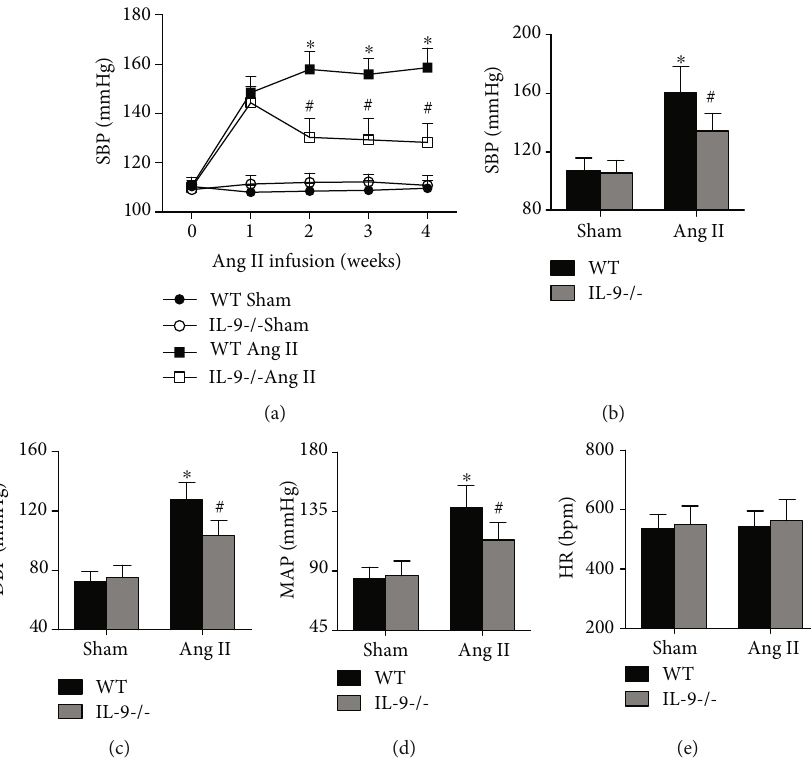
Figure 2: E ff ects of IL-9 KO on Ang II-induced hypertension. (a) Systolic blood pressure (SBP) of saline and angiotensin II-infused mice was measured using the tail-cu ff method. (b – d) SBP, diastolic BP, mean arterial pressure, and heart rate were detected using the Millar Pressure Volume System. N = 10 for each group; ∗ p < 0 : 05 vs. the WT Sham group; # p < 0 : 05 vs. the WT Ang II